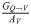
The {δ,β,G
C} space.We plot steady state free cell densities (the first column) and the phage densities (the second column) for various values of (β,G
C) values under two cases: (A) moderately suppressed free-cell CRISPR activity, δ = 0.01 and (B) strongly suppressed free-cell CRISPR activity, δ = 0.0001. G
C is the dimensionless parameter indicating the ratio of spacer deletion rate to spacer acquisition rate. β is a dimensionless parameter indicating the ratio of host to phage protospacer levels. (Regime I) Very high G
C values effectively reduce CRISPR content to very low levels (phage lysis rates are relatively overwhelming) offering no immune advantage to the hosts, resulting in free cell levels of GQ→VAV. (Regime II) Both abortive infection and immunity operate with the available intracellular steady state levels of active and self-targeting spacers. (Regime III) The constraint on δ is not satisfied and the hosts are extinct. (Regime IV) CRISPRs behave as full-fledged abortive infection systems exploiting only the accumulated self-targeting spacers, with phage reactive spacers eliminated due to high G
C values.